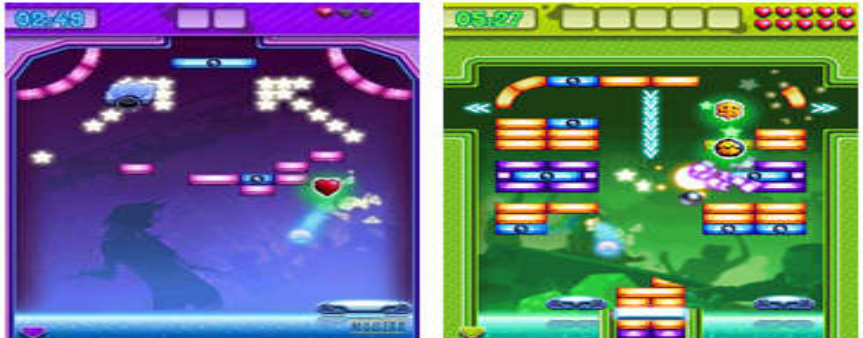
Figure 6. Related levels of Block Breaker Unlimited (from GameLoft).